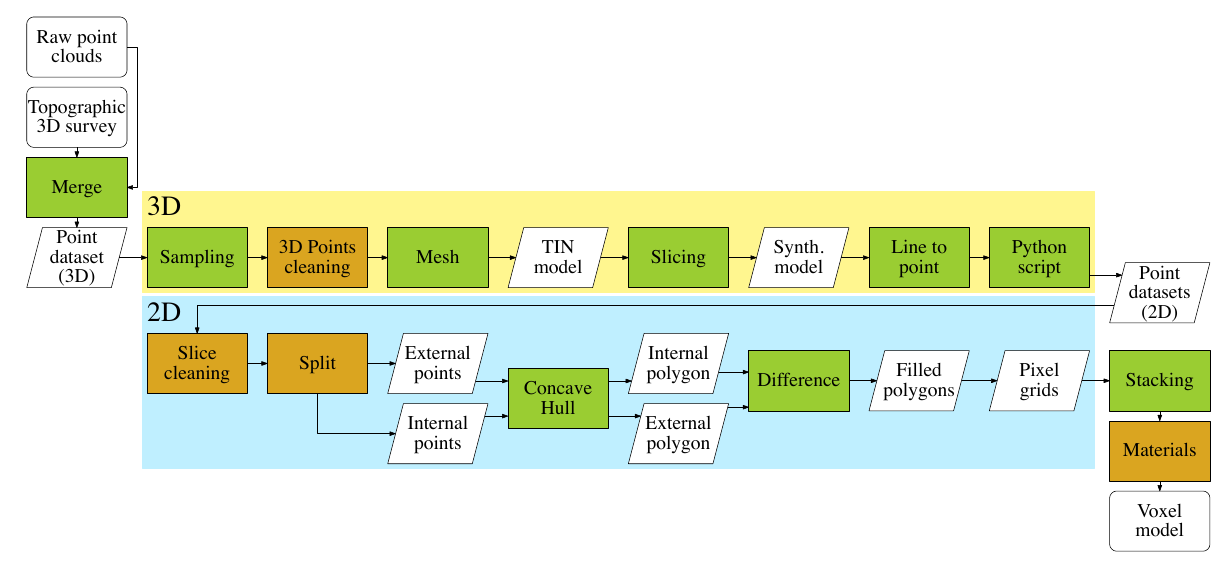
Figure 1. Flowchart for the proposed method: completely automated procedures (green) and semi-automated or manual procedures